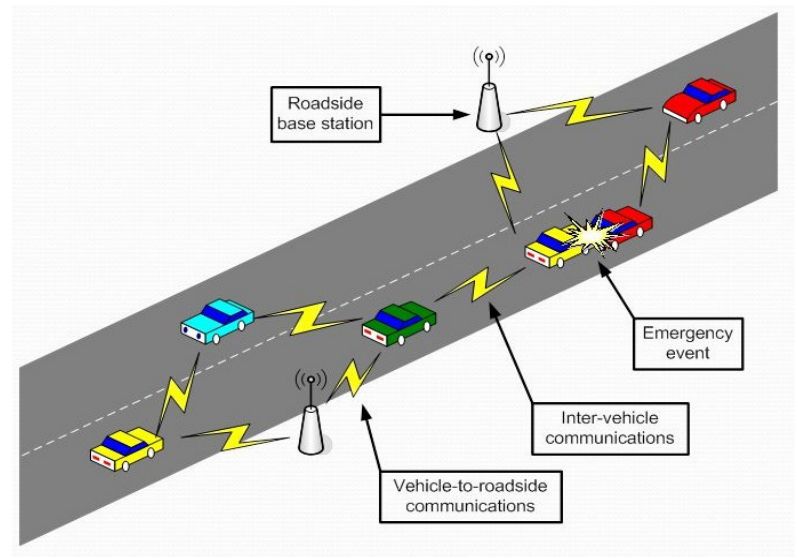
Figure 1. Communication units in VANETs [5].